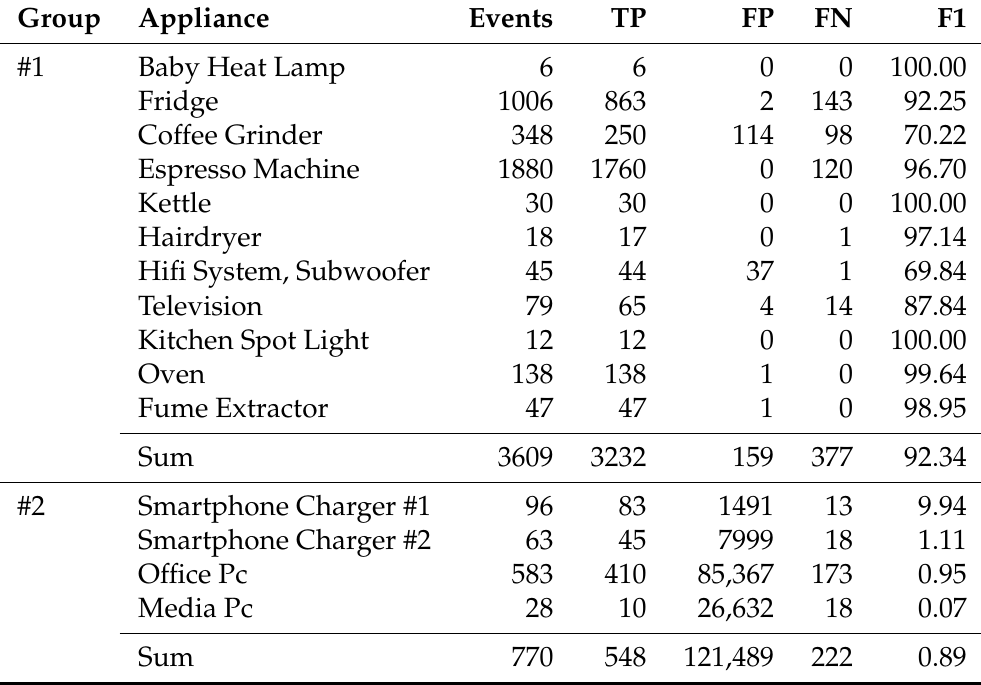
Table 3. Results for the automatic labeling algorithm split into two appliance groups. In #1, appliances are grouped which show distinct states in the power signal in which nearly constant power is drawn. #2 groups appliances that draw variable power. Events marks the number of ground truth events labeled